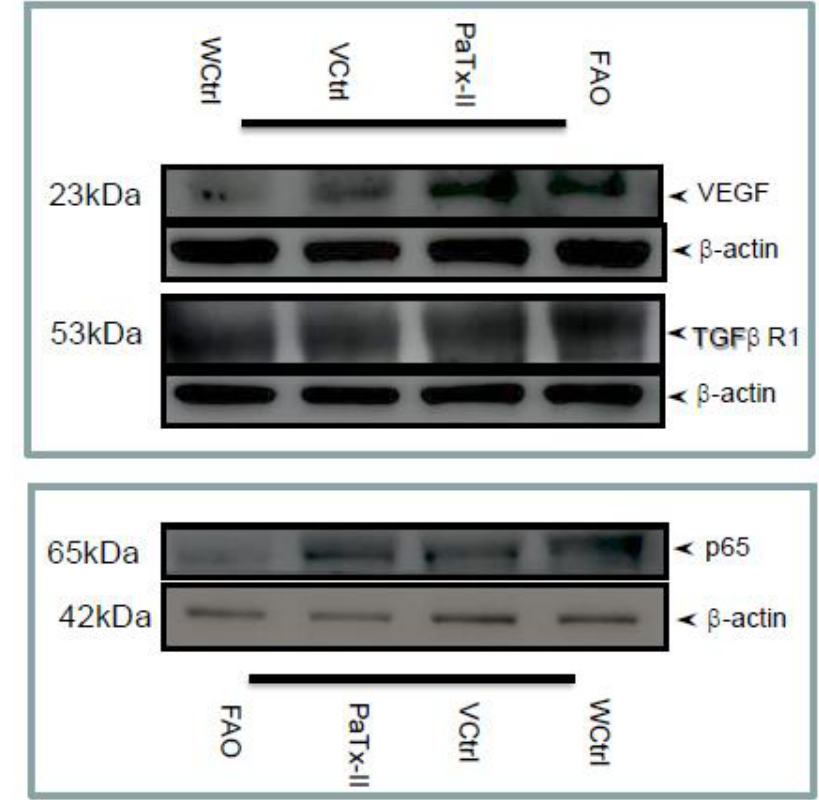
Figure 7. Western blot analysis of the protein extracted from treated infected wound/control tissues. ( A ) Local application of PaTx-II (0.5 mg/kg, bw) or FAO shows a significant up-regulation of